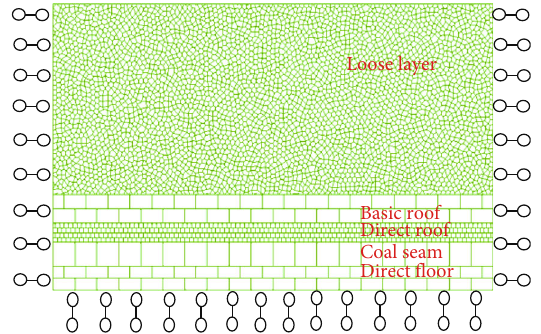
Figure 10: Numerical model for the evolution law of arch